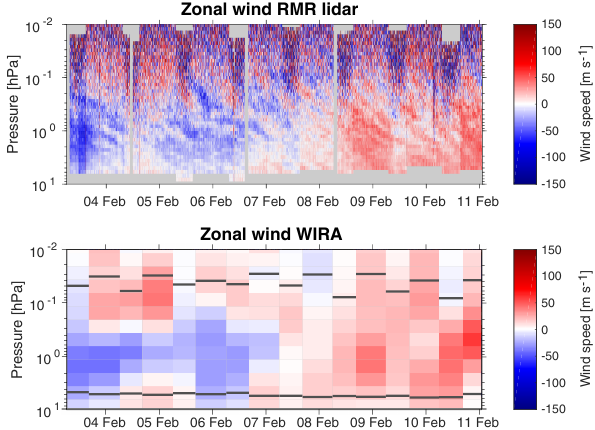
Figure 2. Time series of zonal wind during 187.1h of coincident li- dar and radiometer measurements recorded at Andenes from 3 to 11 February 2017. For better visibility the lidar data are binned to 1km vertical resolution while the temporal resolution is 5min. The trust- worthy altitude range of the wind radiometer data, according to the definition given in Sect. 2.1, is marked by the horizontal dark grey lines. Data outside this range should not be considered as they may substantially be affected by a priori assumptions. All times are ex- pressed in coordinated universal time (UTC) with the ticks at 00:00.